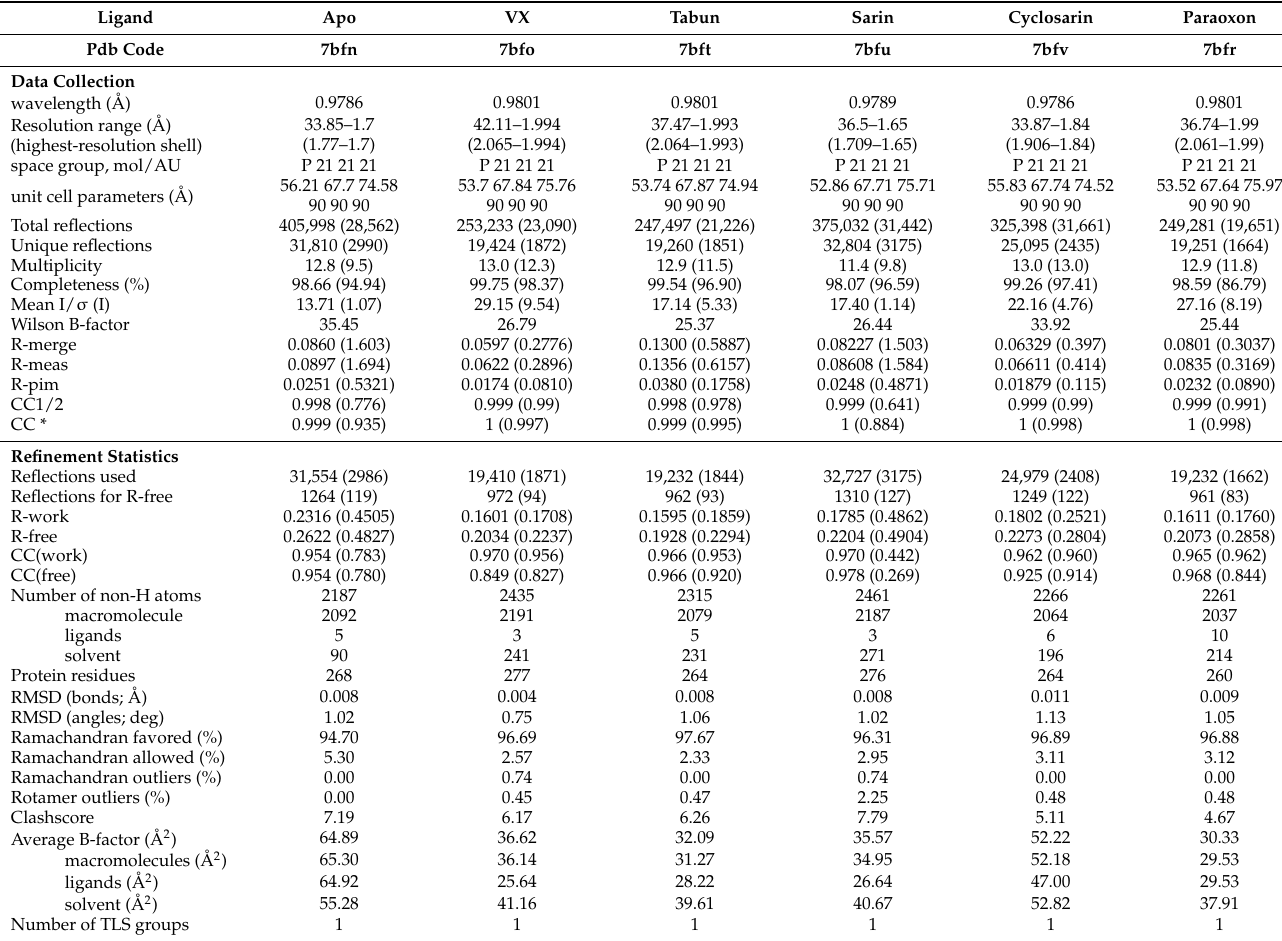
Table 2. Data collection and refinement statistics calculated using Phenix. R-work = Σ |Fo| − |Fc|/ Σ |Fo|, where Fo and Fc are observed and calculated structure factors. R-free set uses about 1000 randomly chosen reflections. Statistics for the highest-resolution shell are shown in